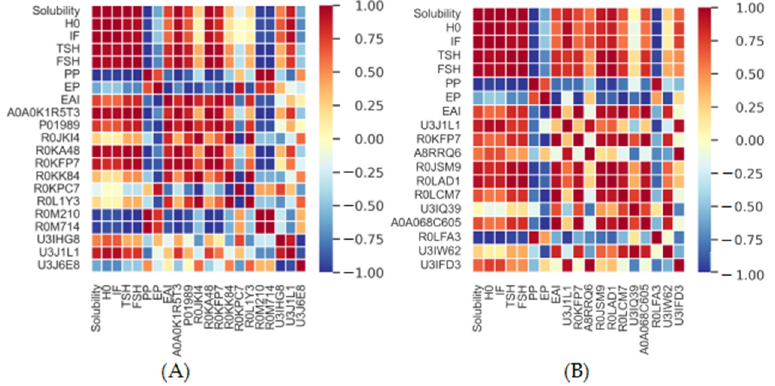
Figure 7. Correlation analysis. IF: intrinsic fluorescence; PP: protein particle; EP: emulsion particle. ( A ) The top 10 proteins of the highest signal strength; ( B ) Phosphorylated proteins.